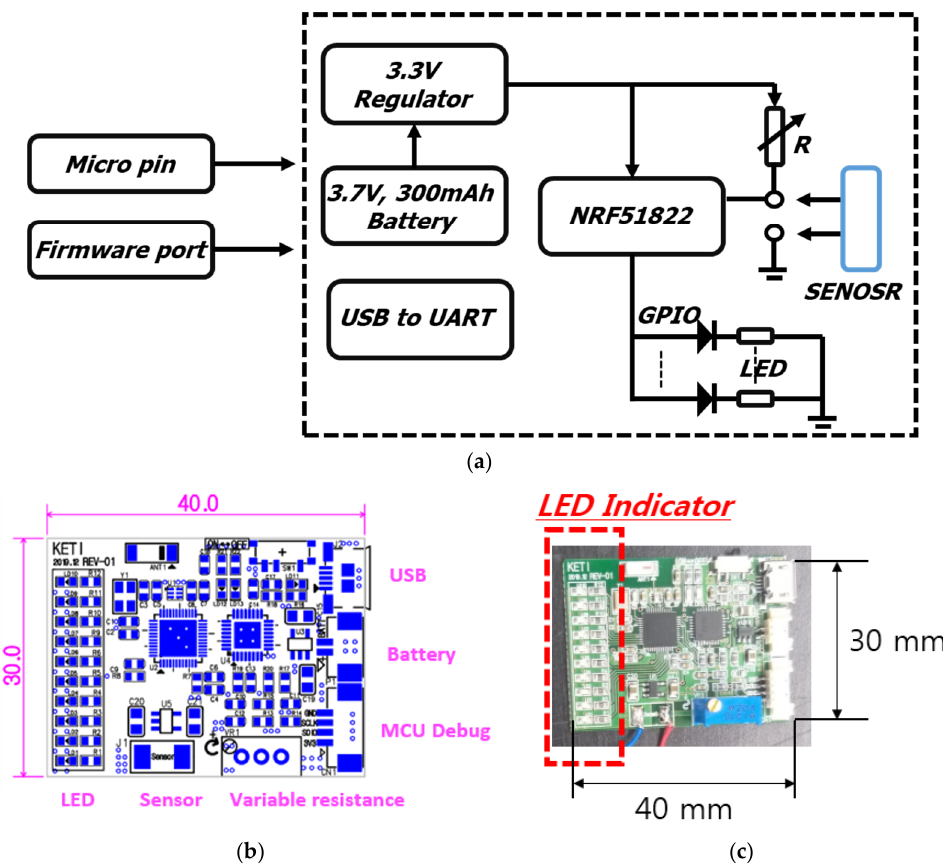
Figure 5. Resistant Fiber Sensor Read-out Wireless Communication Module: ( a ) Sensor module system block diagram (data transmission unit); ( b ) Communication module PCB design; ( c ) Read-out Wireless Communication Module.